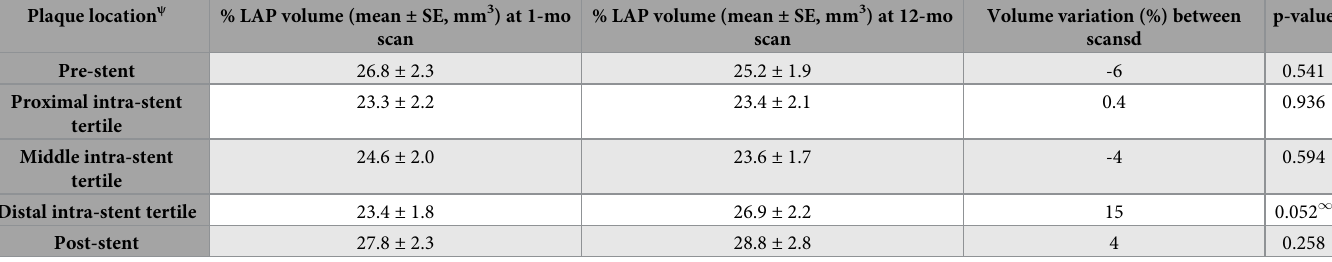
Table 11. Relative LAP volume at 1- and 12-month follow-up by plaque location (pre-, 1 st , 2 nd , 3 rd intra-stent tertiles, and post-stent blocks). Plaque location